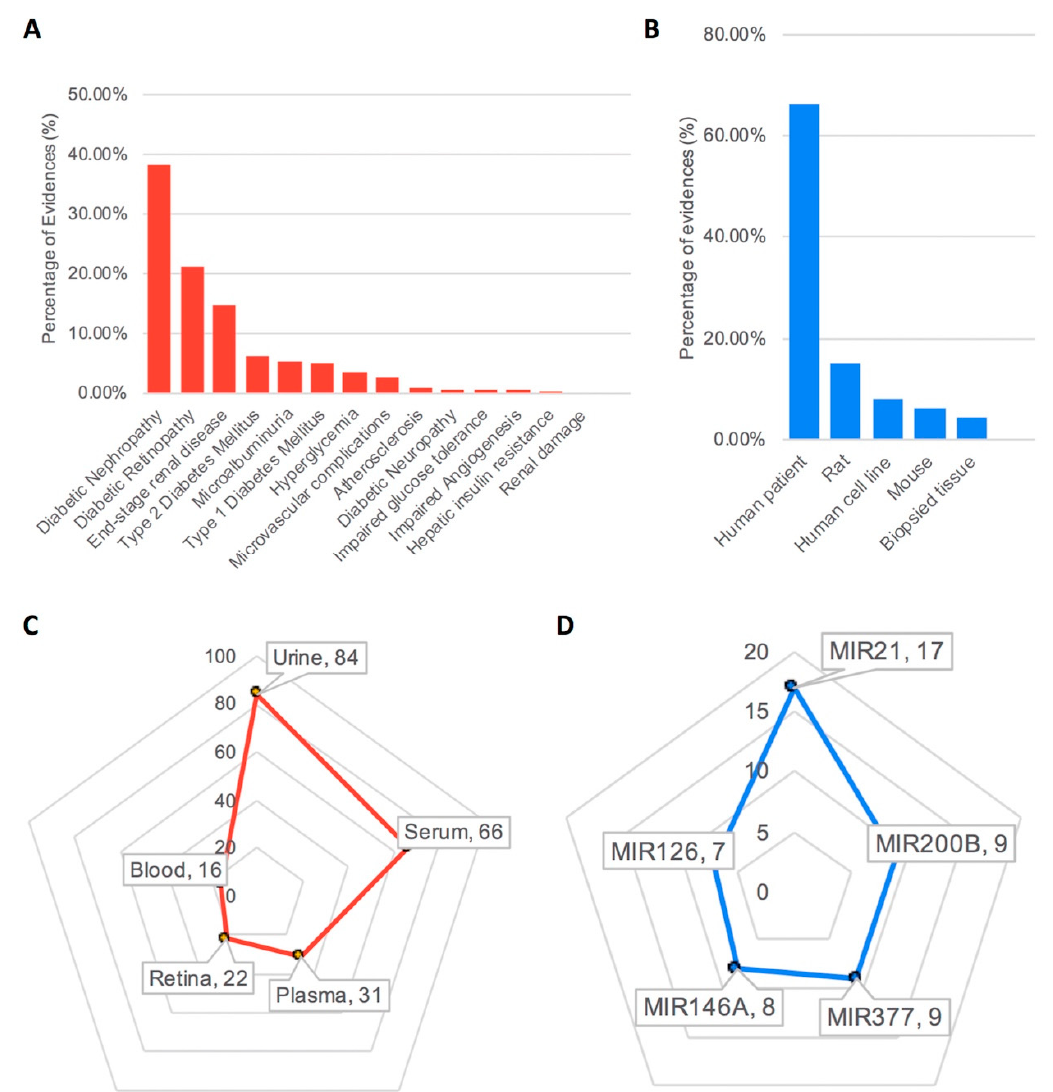
Figure 1. miR2Diabetes statistics. ( A ) Percentages of publication evidence contained in miR2Diabetes related to certain diabetic microvascular complications. ( B ) Percentages of miR2Diabetes publications related to specific organisms / tissues. ( C ) A pie chart of the top 5 experimental samples connected to miRNA dysregulation observations. ( D ) A pie chart of the top 5 miRNAs contained in our database.